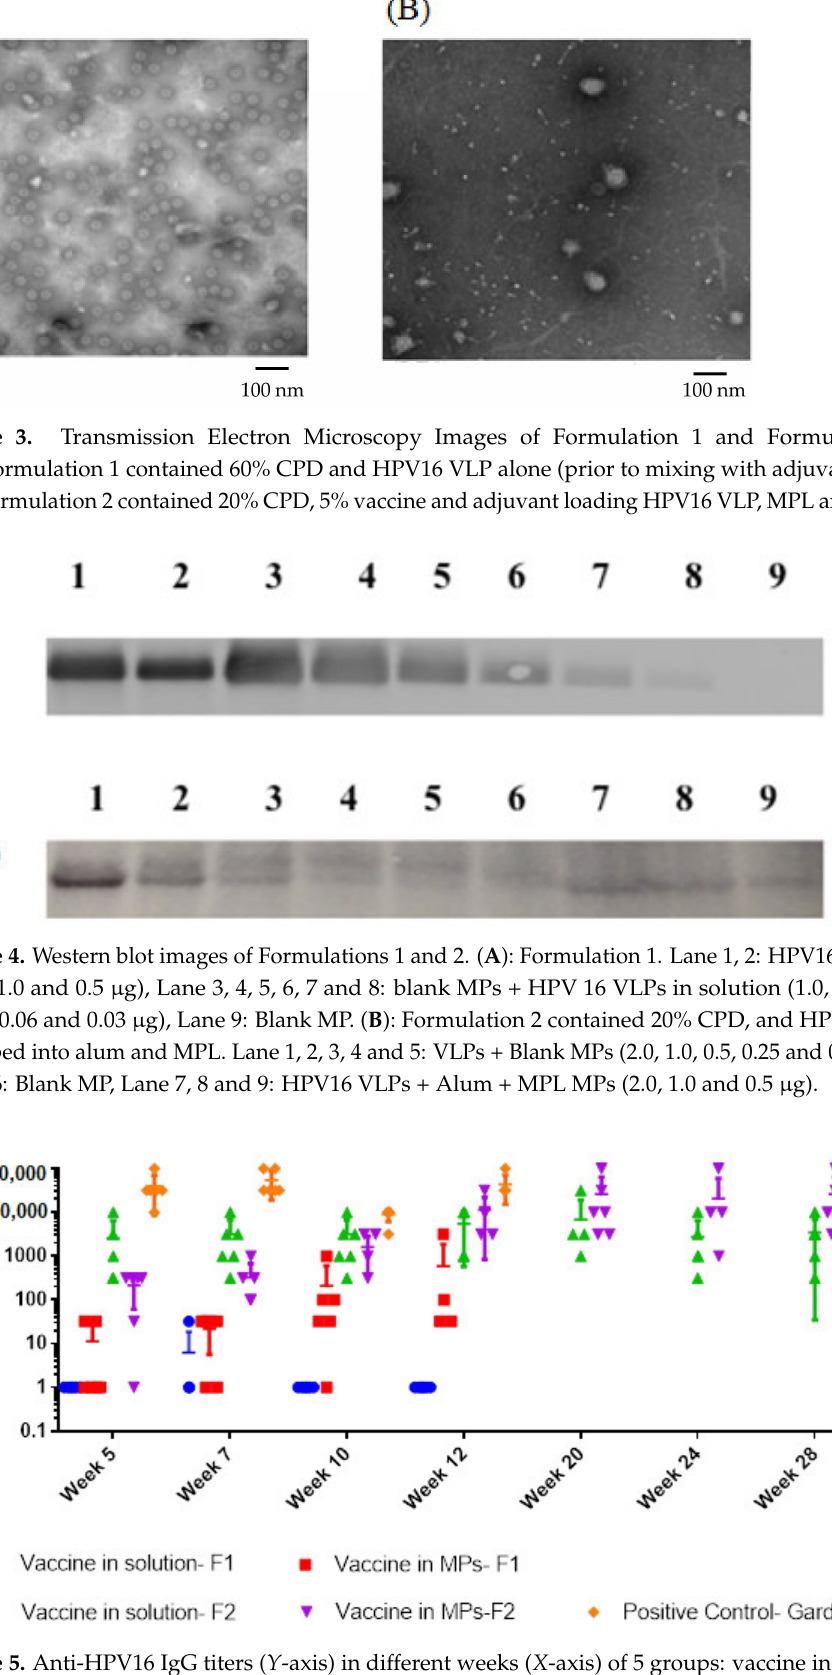
Figure 5. Anti-HPV16 IgG titers ( Y -axis) in different weeks ( X -axis) of 5 groups: vaccine in solution and in MPs using Formulation 1 (containing 60% CPD, 15% HPMCAS, 15% EC)—transdermal route,